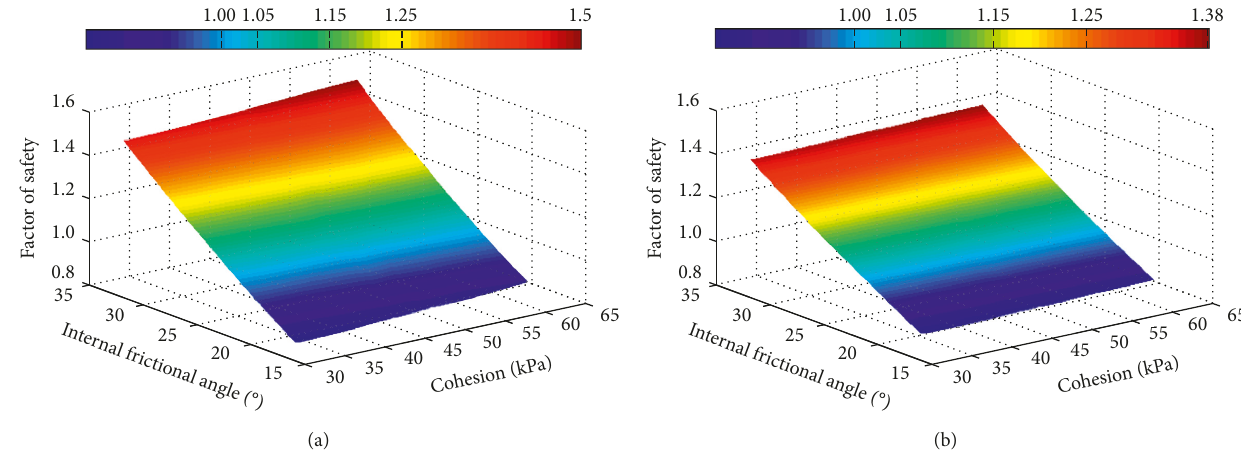
Figure 14: Safety factors under different shear strength: (a) the 3rd in Zone I; (b) the 1st in Zone II.